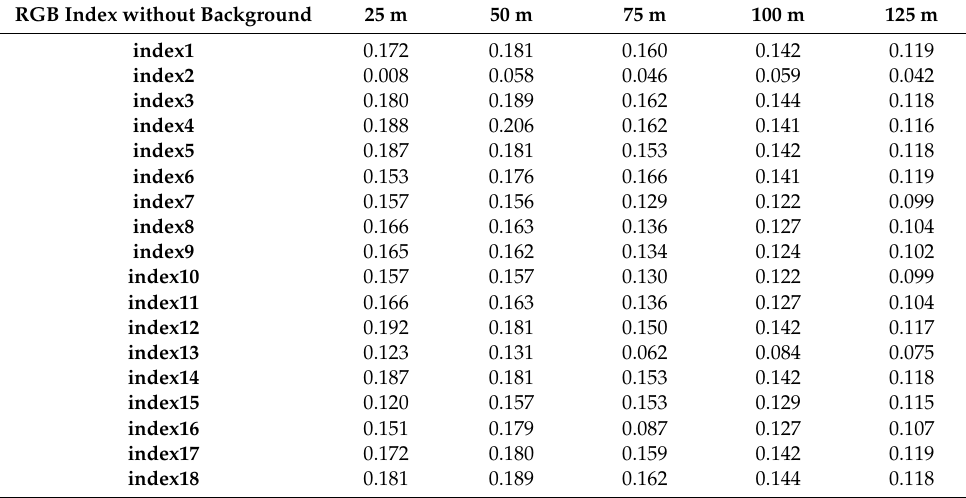
Table A3. The R 2 between vegetation indices calculated from RGB and chlorophyll contents using the images without